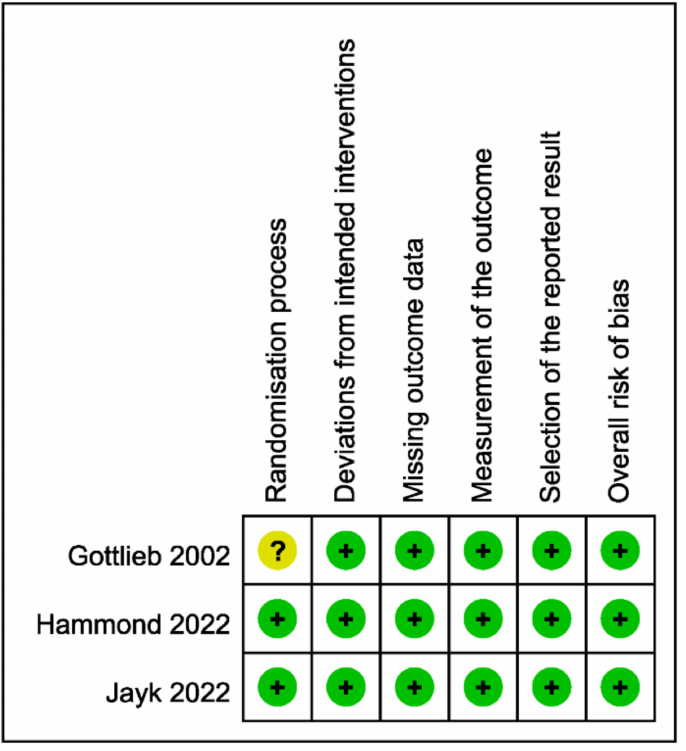
Figure 2. Risk of bias assessment [5–7].